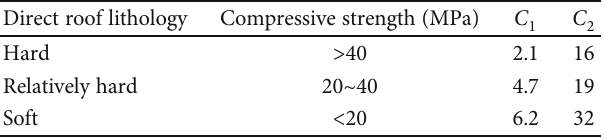
Table 2: Coe ffi cients for the height of the caving zone. Direct roof lithology